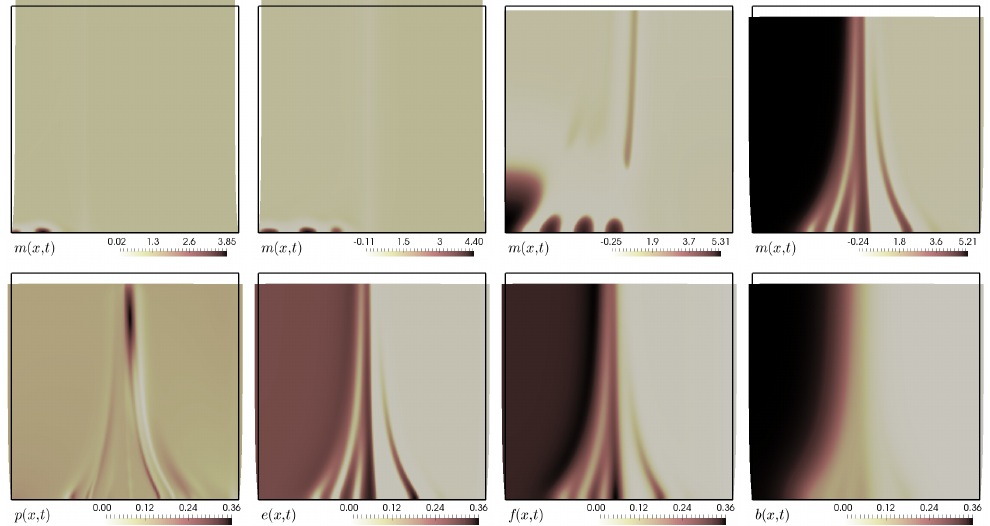
Figure 6. Evolution of the mesenchymal cell concentration at t = 160,280,400,520 under periodic traction applied on the top edge of the domain ( top ); and snapshots of fluid pressure, epithelium, FGF, and BMP at t = 520 ( bottom